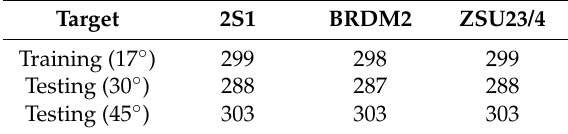
Table 6. The number of images for training and testing about the three targets under EOC. Target 2S1 BRDM2 ZSU23/4